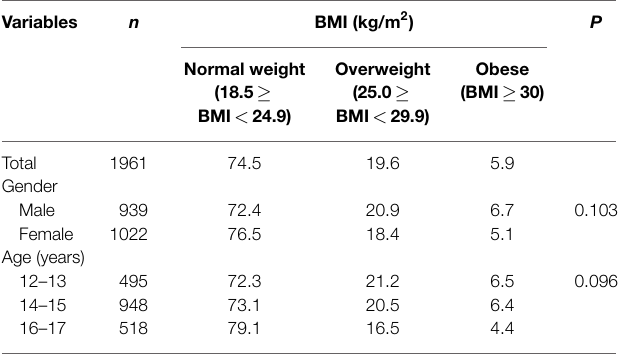
TABLE 1 | BMI distribution in the sample of adolescents according to the different variables in the study